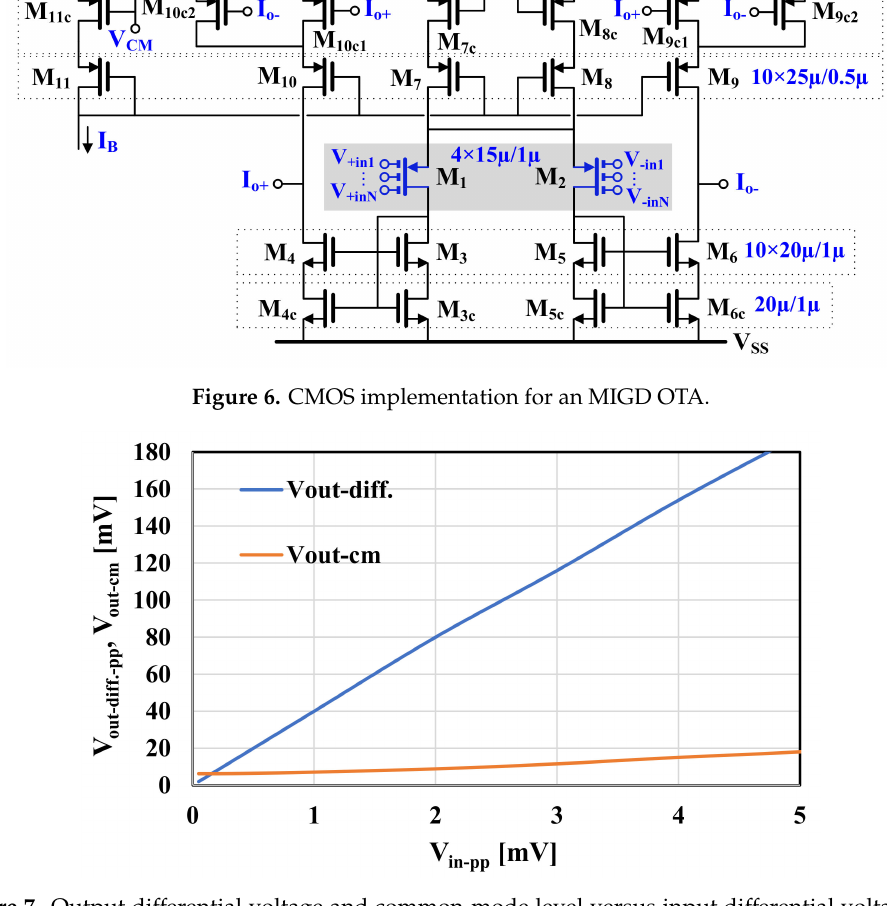
Figure 7. Output di ff erential voltage and common-mode level versus input di ff erential voltage for unloaded OTA in Figure